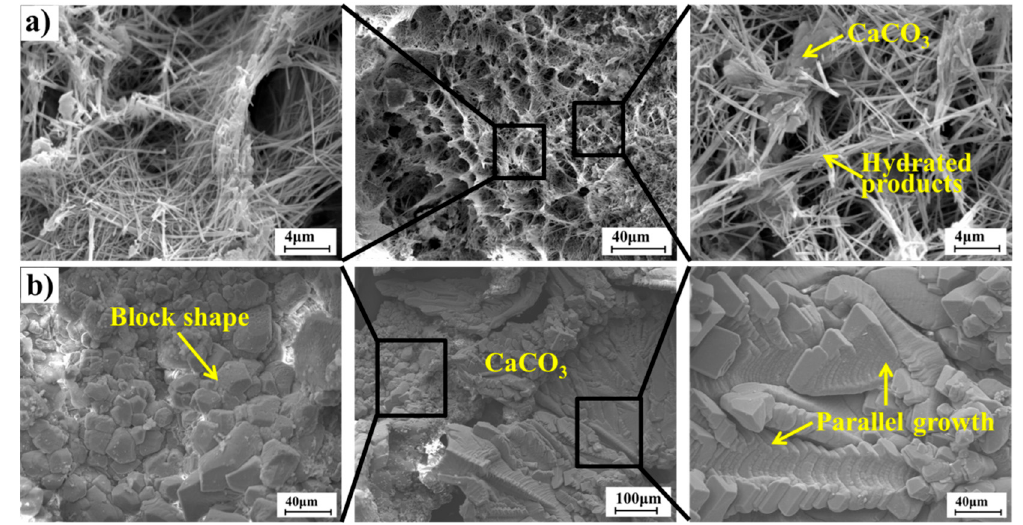
Figure 15. SEM analysis of self-healing products ( a is self-healing for 7 days, b is self-healing for 30 days). 30